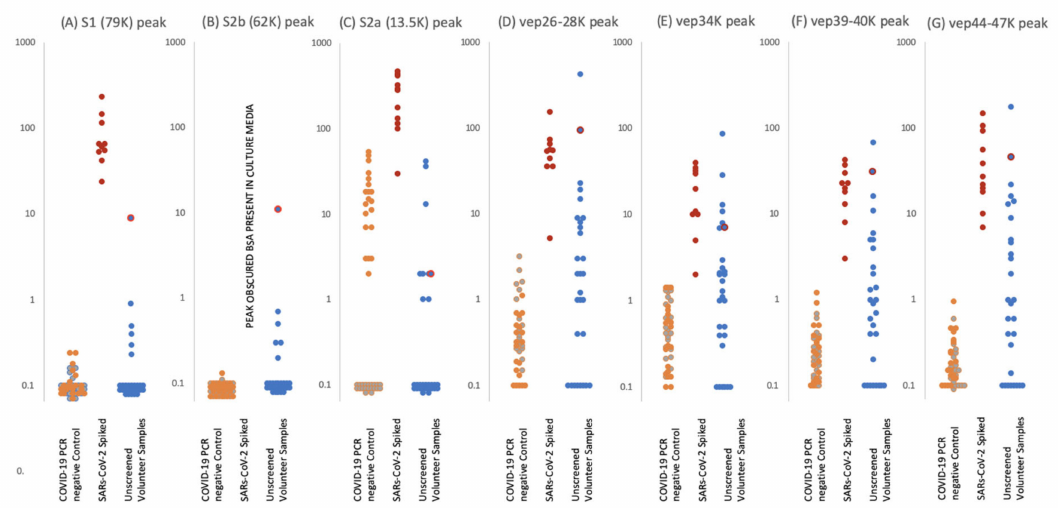
Figure 5. Levels of proteolytic S protein fragments and viral-associated protein peaks in samples groups. Culture supernatant from Vero cells infected with Sars-Cov-2 were spiked into ten gargle / saliva samples at 1–10%. The viral load in these culture media was determined as at 10 4 to 10 5 PFU / mL. Gargle / saliva were collected from two individuals, with and without a cough, who were confirmed as RT-PCR Covid-19 negative at the time of gargle / saliva collection. These were analysed 20 times each. A series of 30 gargle / saliva was collected from volunteers, but COVID-19 PCR status at time of sampling was not known. These were analysed only once each. All samples were acetone precipitated, subjected to viral envelope protein solubilisation and analysed by MALDI-ToF mass spectrometry. Target peak intensities were then measured. Panel ( A ) illustrates the levels of each analysed sample for Spike protein fragment S1 peak at 79,000 m / z ; panel ( B ) Spike protein fragment S2b at 63,000 m / z and panel ( C ) Spike protein fragment S2a at 13,500 m / z . The maximal intensity was also measured for broad glycoproteins peaks, considered to originate from other viral envelope proteins (VEPS), at 26,000–28,000 m / z (vep26–28K–panel ( D )), 34,000 m / z (vep34K panel ( E )), 39,000-40,000 m / z (vep39–40K–panel ( F )) and 45,000-47,000 m / z (vep45K–panel ( G )). Red dots represent levels of peak intensity for the spiked gargle / saliva samples, orange dots represents levels of peak intensity for COVID-19 RT-PCR negative control 1 samples, grey dots represent levels of peak intensity for COVID-19 PCR negative control 2 samples and blue dots represent levels of peak intensity for unscreened volunteer gargle / saliva samples. Blue dots with red circle borders are the values recorded for volunteer subject